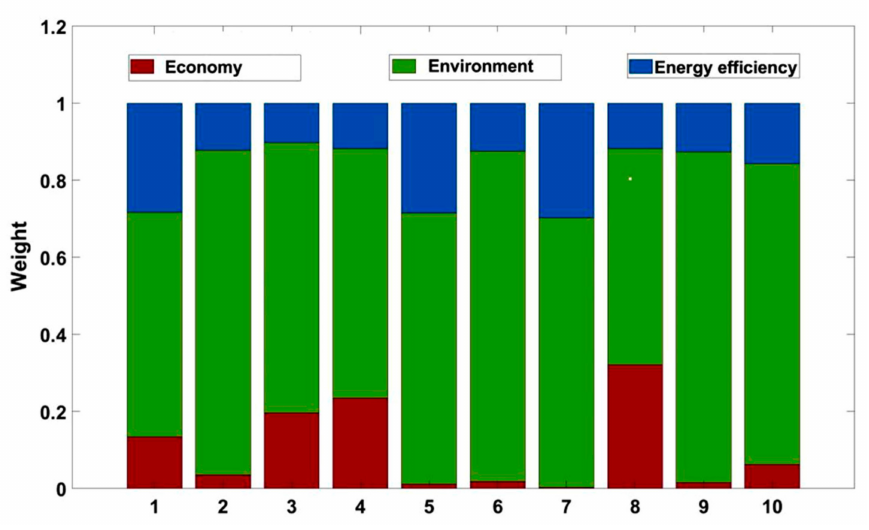
Figure 18. Objective weight comparison of NSGA-III.